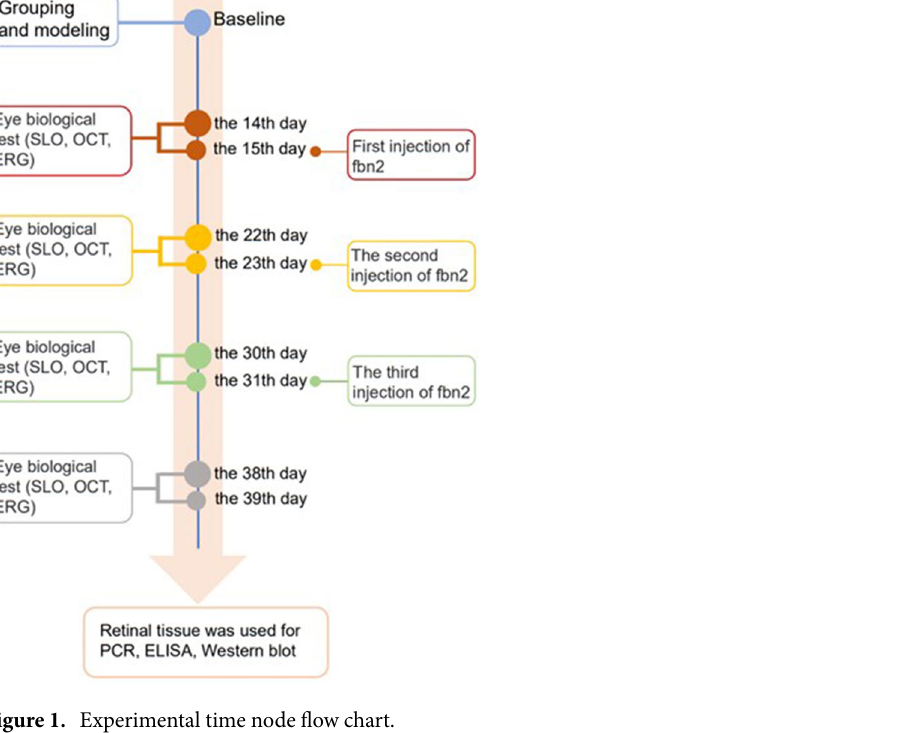
Figure 1. Experimental time node flow